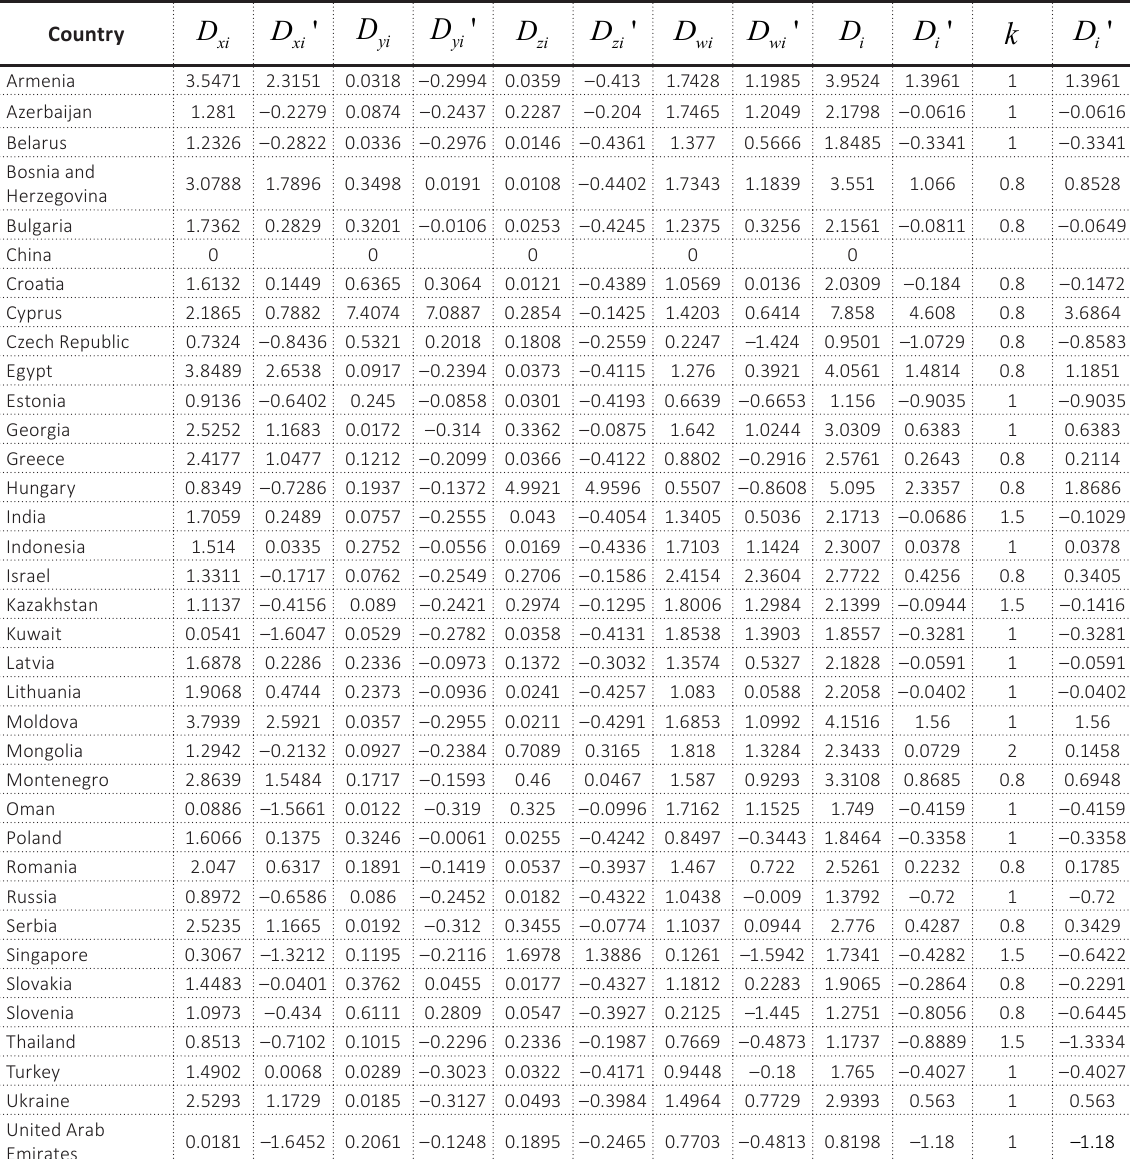
Table B1. Indicators for the Euclidean distance between China and the BRI countries in 2018